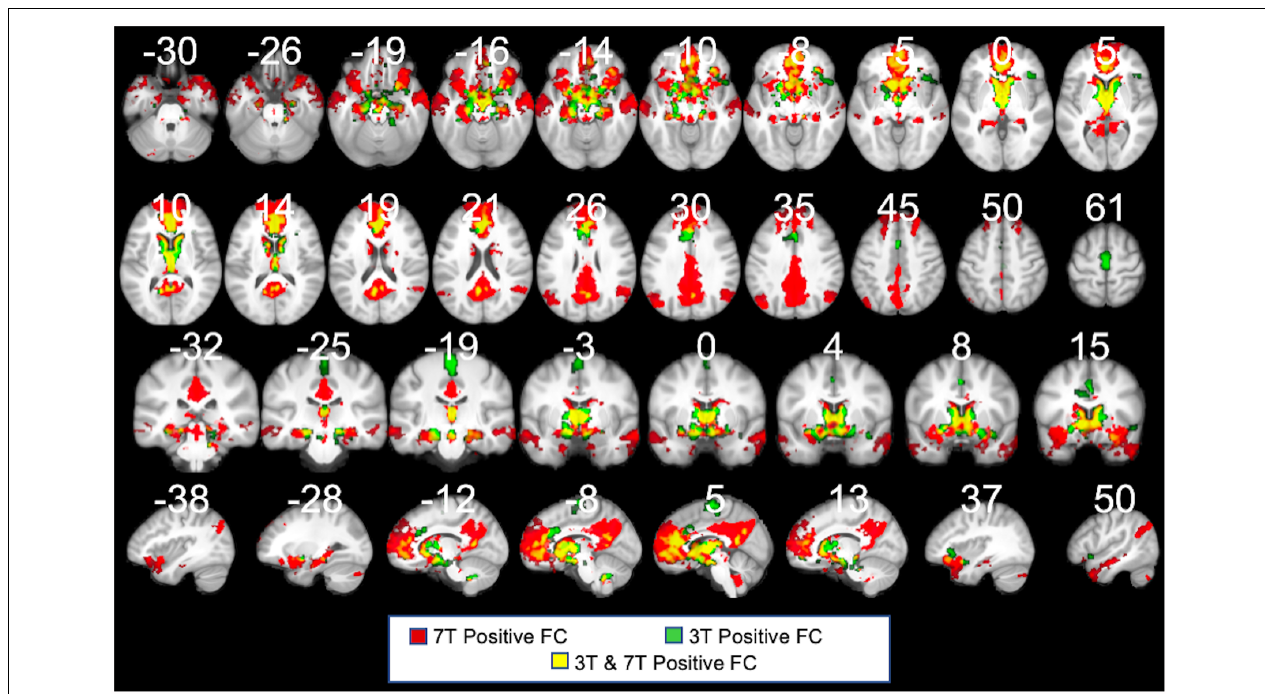
FIGURE 7 | 3T PVT positive functional connectivity (green) showed with the 7T results (shown in red). Regions shown in yellow demarcate regions that showed positive FC in both the 7T and 3T datasets. Each maps controls for the average signal from the rest of the thalamus. All results thresholded at p TFCE-FWE <